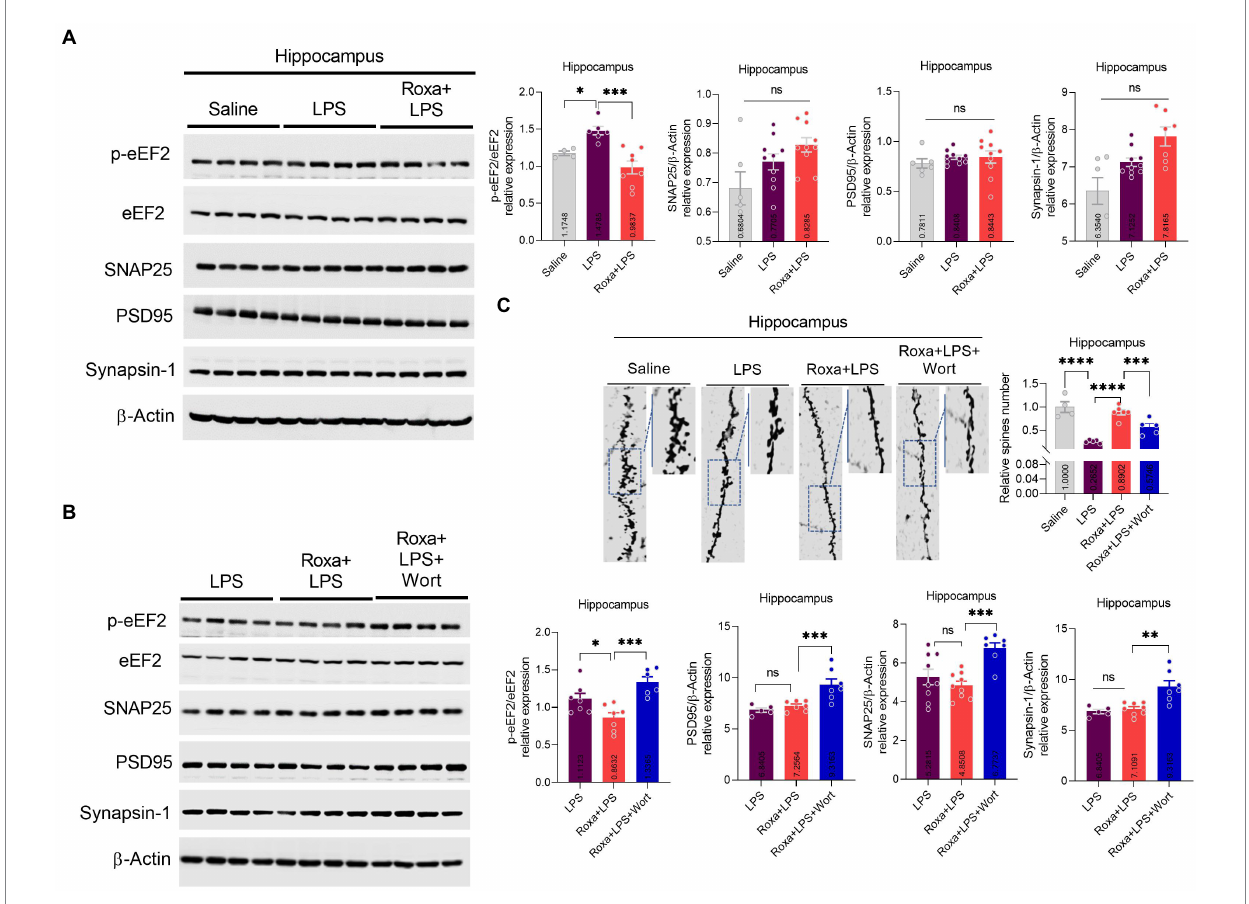
FIGURE 6 Changes in the expression of eEF2, SNAP25, PSD95, and Synapsin-1, and spine numbers after Roxa and LSP treatment. (A,B) Representative immune blots show the expression of p-eEF2, eEF2, SNAP25, PSD95, and Synapsin-1 levels in the hippocampus of subjects. All the values were normalized with β -Actin. ( C) Golgi staining showing spine density and column graph showing spine numbers n = 3–5. Image lab software was used for blots quantitative analysis and was analyzed via GraphPad prism. Data were expressed as mean ± SEM, One-way ANOVA, followed by post hoc analysis. p = <0.05 were considered significant. * p < 0.05, ** p < 0.01), *** p < 0.001, **** p < 0.0001. ns: